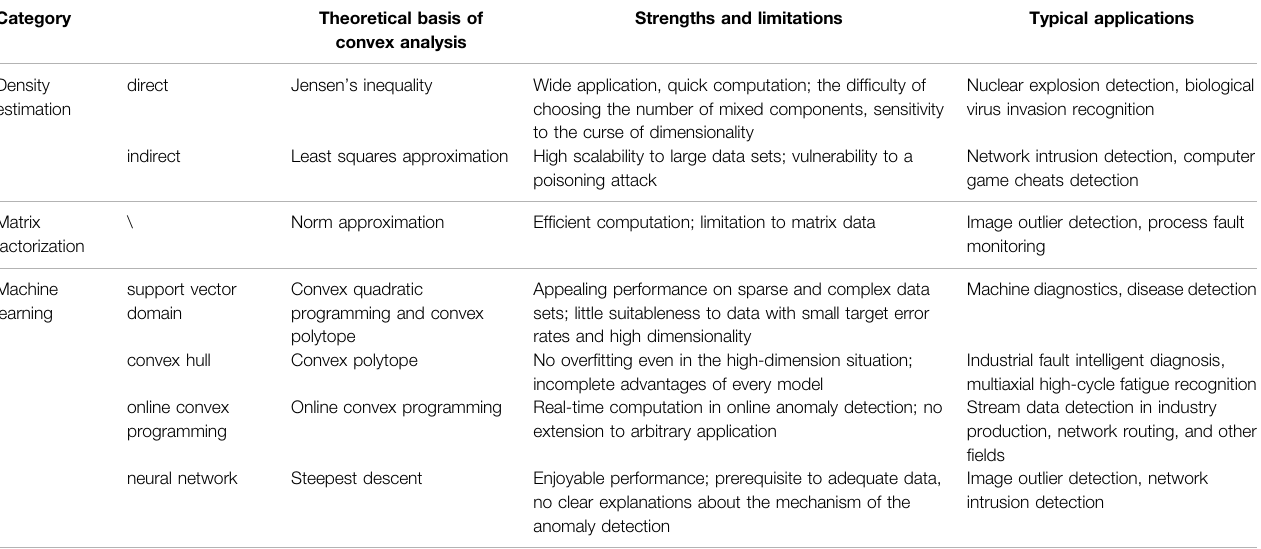
TABLE 4 | Summary of convex theory and its application in this